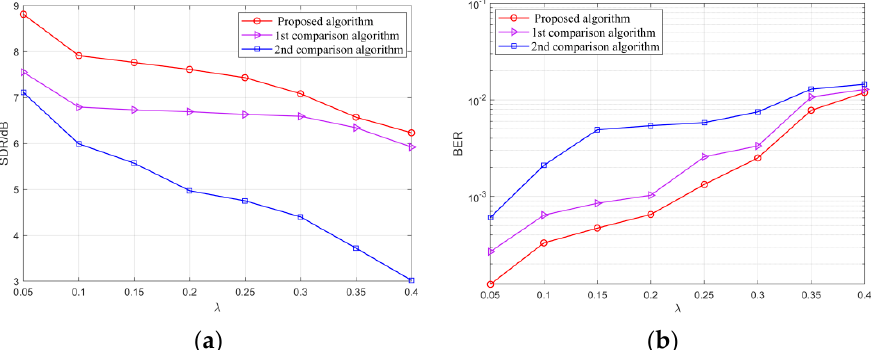
λ Figure 14. ( a ) The SDR of different modulation signals with different ; ( b ) The BER of different Figure 14. ( a ) The SDR of different modulation signals with different λ ; ( b ) The BER of differ- λ modulation signals with different . The 1st and 2nd comparison algorithms are given in litera- ent modulation signals with different λ . The 1st and 2nd comparison algorithms are given in ture 8 and literature 10, respectively. literatures [8,10], respectively.